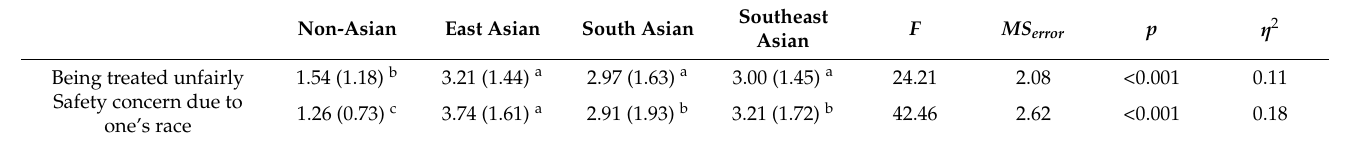
Table 2. Means and standard deviations for the race/ethnicity groups related to their racism